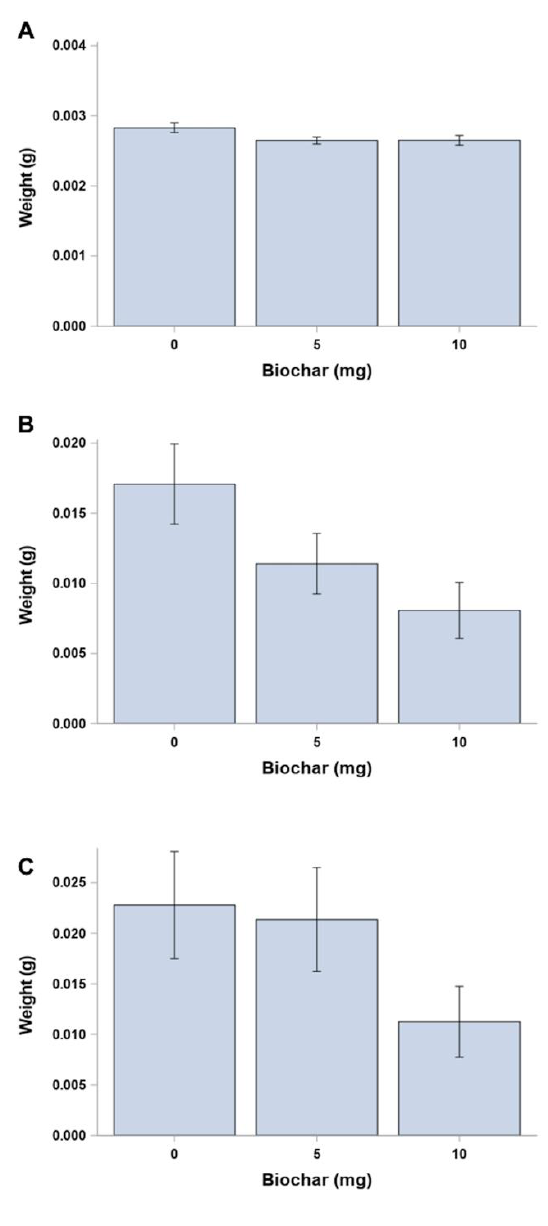
Figure 2. Mean larval weights (g ± SEM) of O. pseudotsugata larvae reared on synthetic diet with dry biochar applied to the surface at three concentrations (0, 5 and 10 mg). Initial weights were taken at ( A ) day 0 for all second instar larvae prior to randomly assignment to each treatment rate, then again at ( B ) day 12 and ( C ) day 24 for surviving larvae.